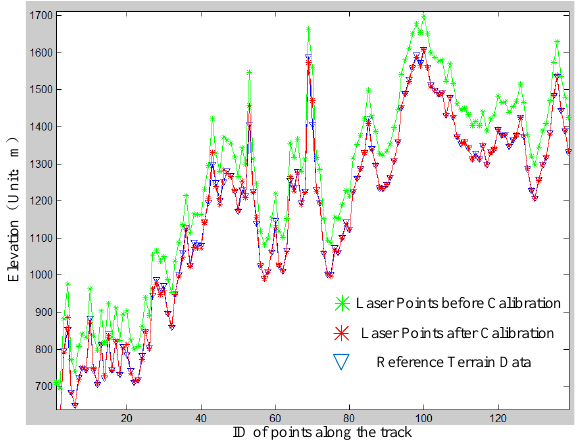
Figure 6. Track 382 laser footprint points and reference terrain data before and after pointing angle